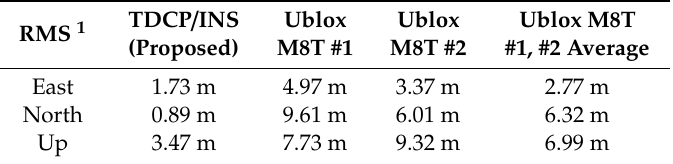
Table 4. Maximum errors of the proposed method with other filtered solutions (1 h)